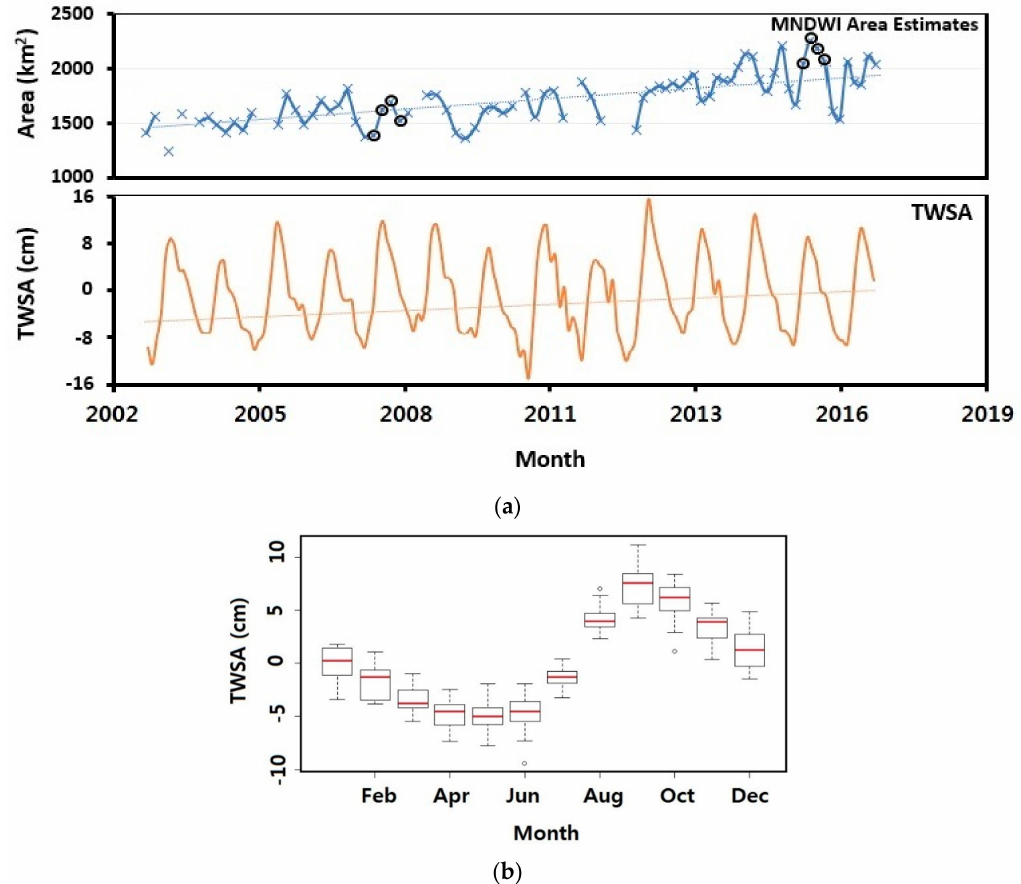
Figure 10. ( a ) Averaged monthly area and averaged monthly TWSA averaged over Lake Chad. The orange line represents the linear trend of the TWSA. The black circles represent selected monthly areas estimates of 2007 and 2015 illustrated in Figure 9a. ( b ) Monthly TWSA